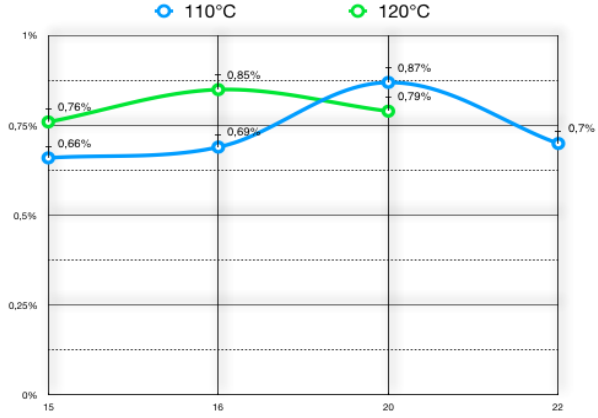
ff erent times (15, 16, 20 and 22 min).